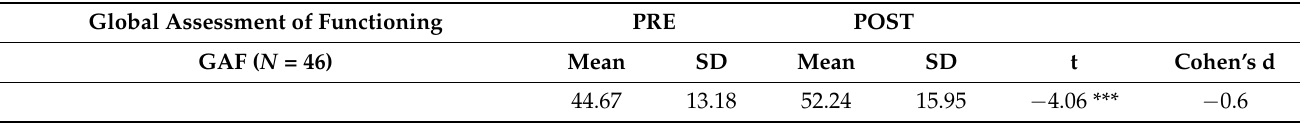
Table 5. GAF. Difference in the pre-/post-intervention means.